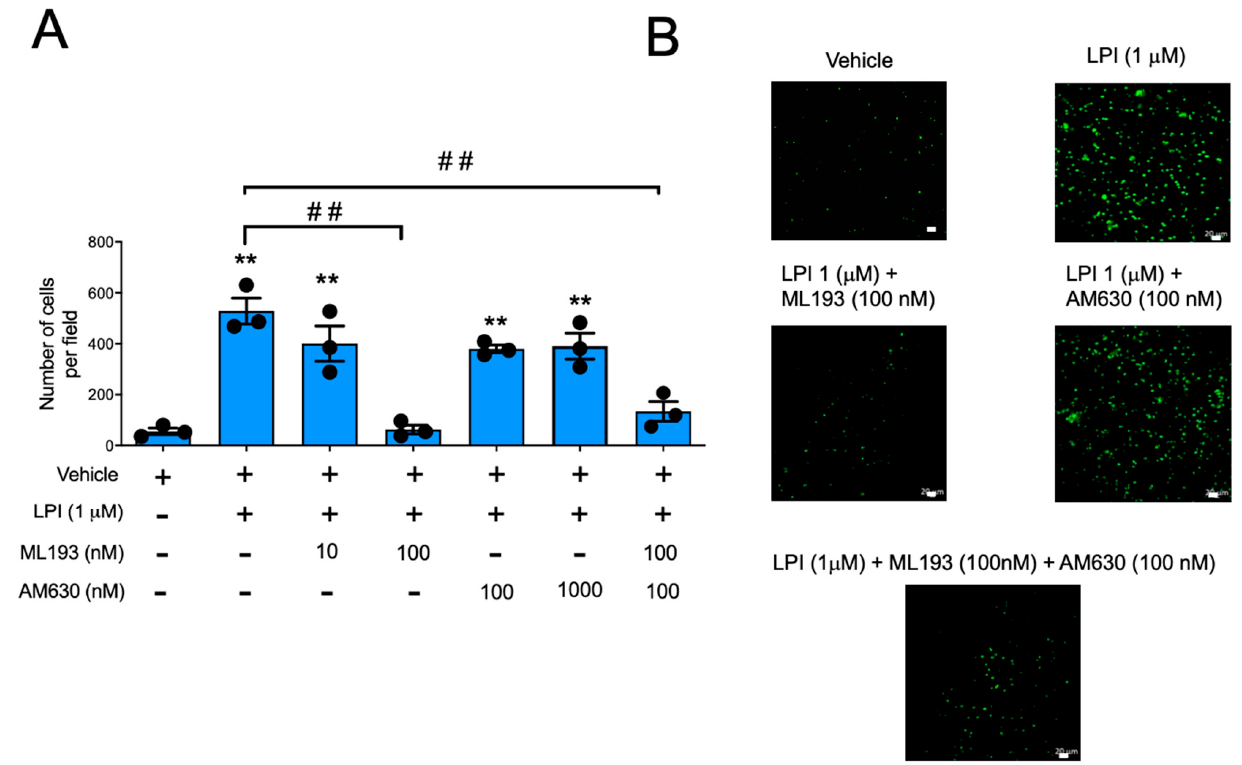
Figure 4. LPI-induced chemotaxis is mediated by GPR55, but not CB2 receptors in BMMCs. Panel ( A ): BMMCs were placed in the Boyden’s chamber to quantify migration towards LPI in the presence of ML193, AM630, or a combination of both antagonists. Data in graph are presented as the mean ± SEM of at least three independent experiments performed with distinct cell cultures; ** p < 0.01 vs. vehicle; ## p < 0.01 vs. LPI. Panel ( B ): representative image of a Boyden’s chamber combination of both antagonists (100 nM ML193 + 100 nM AM630). No signi fi cant di ff erence was